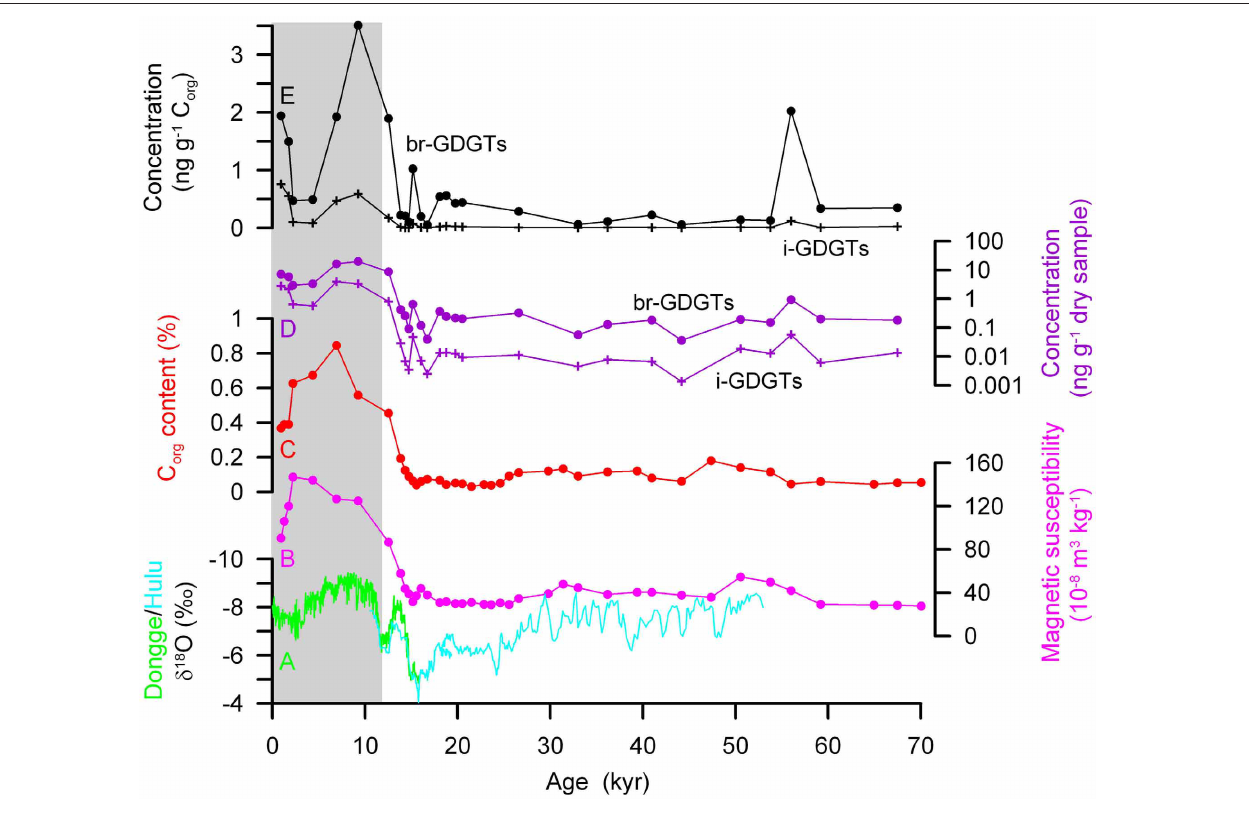
FIGURE 4 | Variations down the loess-paleosol sequence at Yuanbao section of (B) magnetic susceptibility, (C) C org content, (D) concentrations of i-GDGTs and br-GDGTs in dry samples, and (E) C org -content normalized concentrations of i-GDGTs and